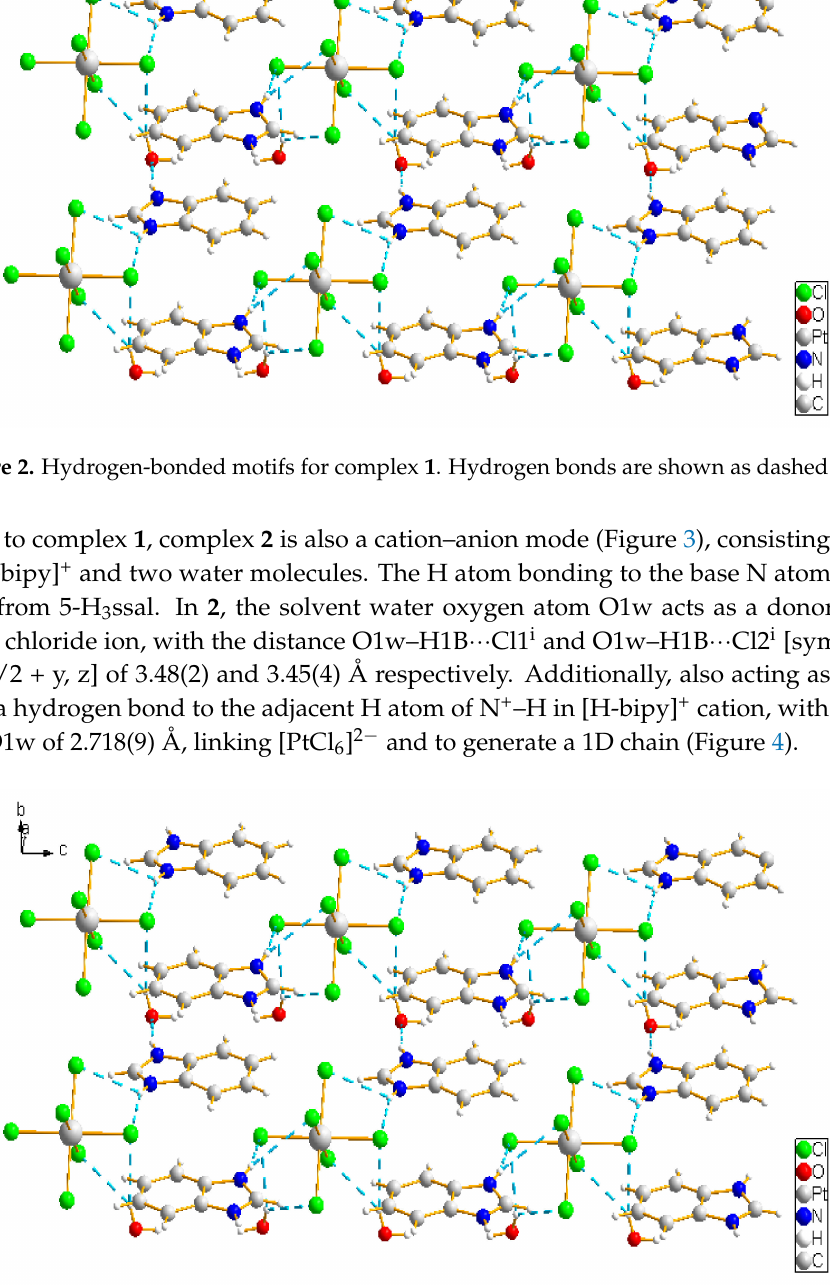
Figure 3. View of the asymmetric unit of complex 2 with the numbering scheme. The thermal probability is drawn at 30%. Symmetry code: i = − x, − y, −